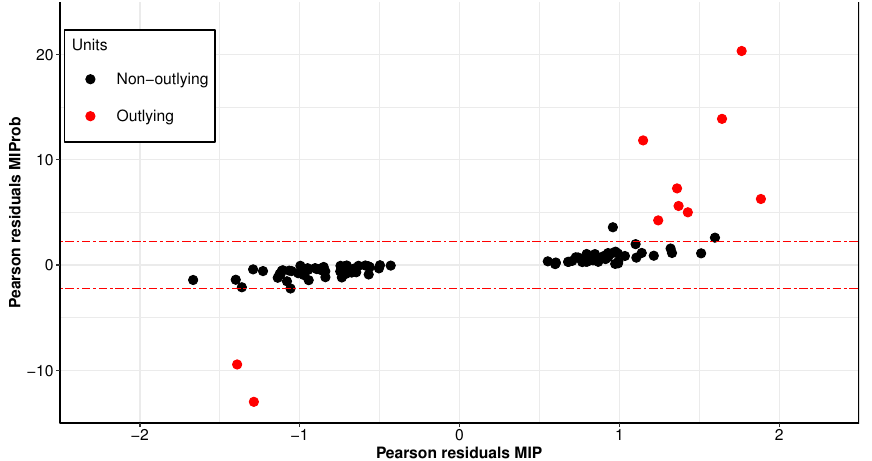
Figure 3. Pearson residuals for MIProb and MIP. Outlying cases detected by MIProb are highlighted in red. Horizontal red lines represent the 0.0125 and 0.9875 quantiles of the standard normal distribution.